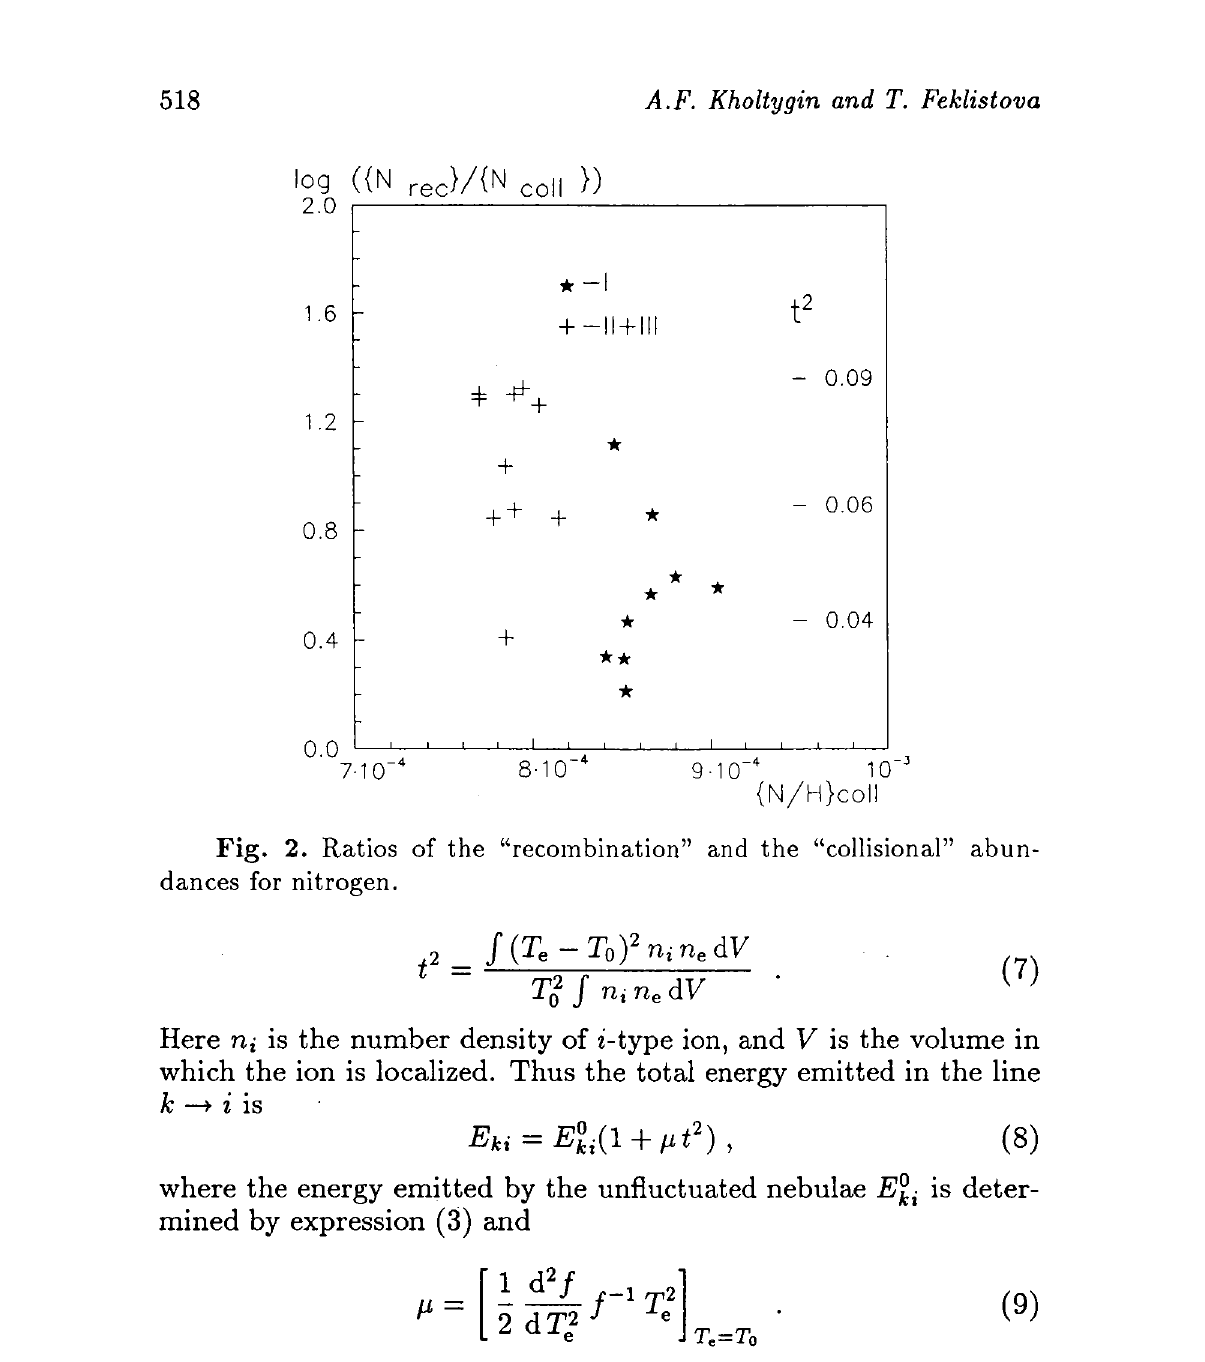
Fig. 2. Ratios of the "recombination" and the "collisional" abun- dances for